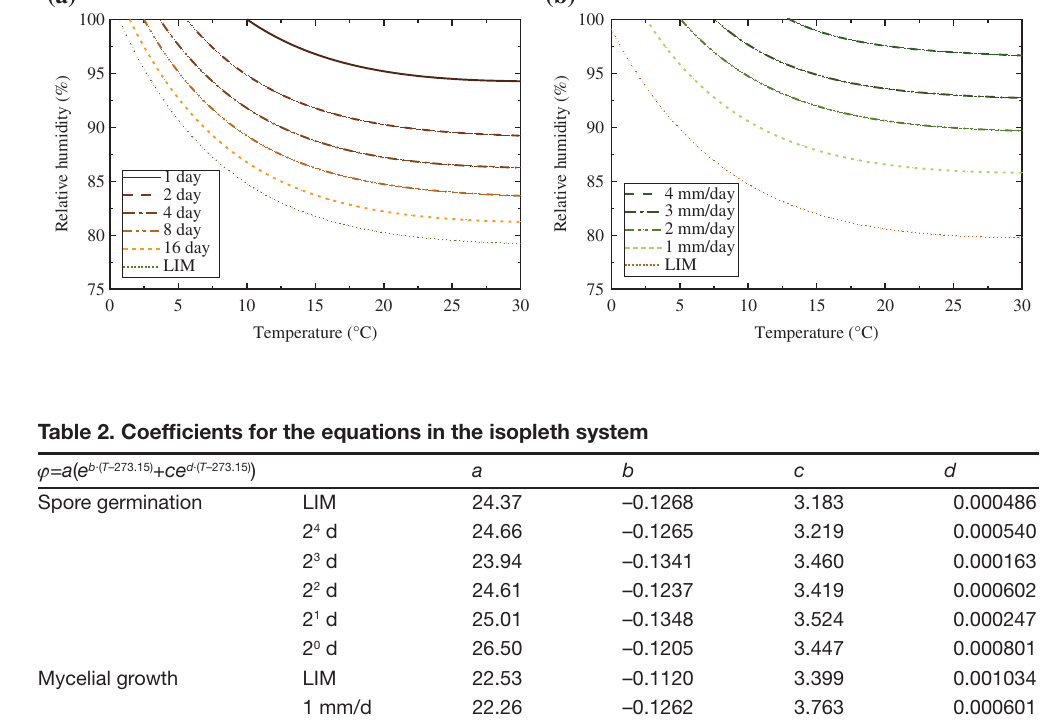
Isopleth systems for the biologically adverse recyclable building materials: (a) spore germination rate, and (b) mycelial growth